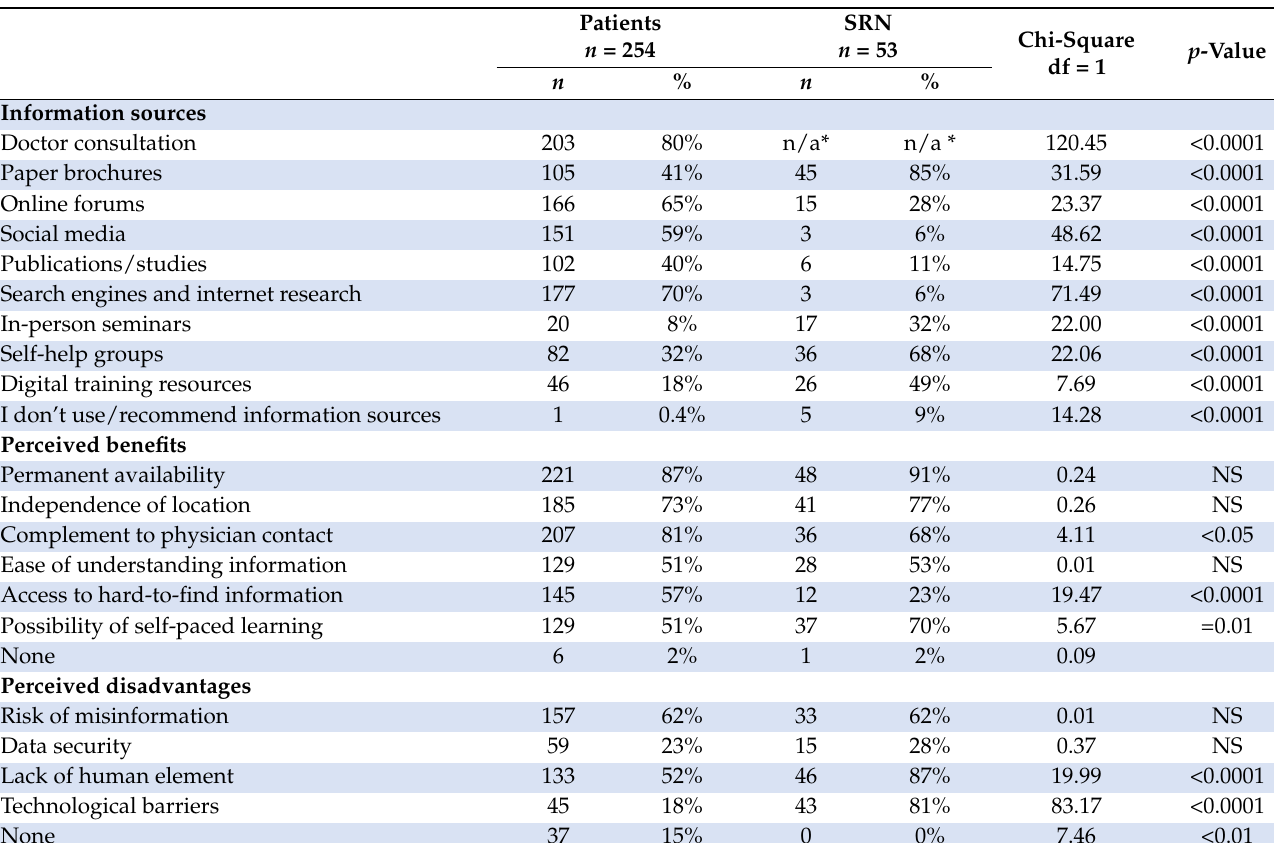
Table 5. Information sources, perceived benefits and perceived disadvantages of digital solutions by participant